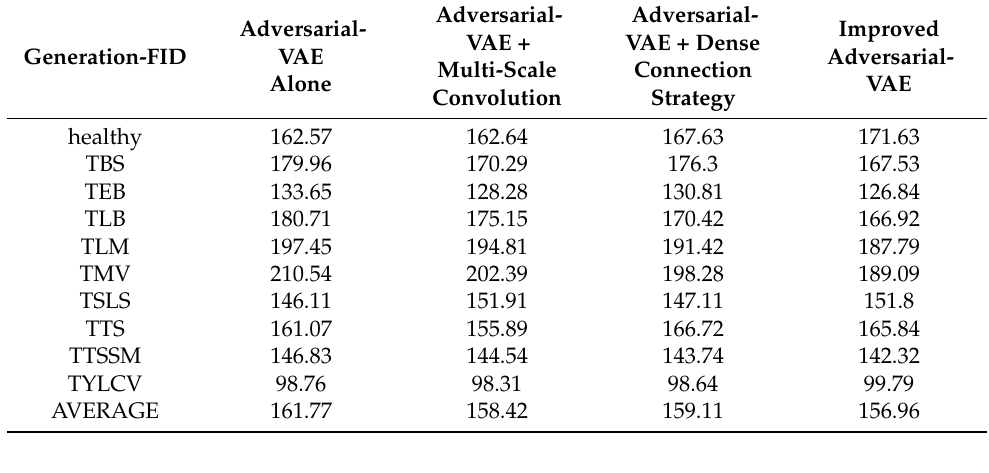
Table 7. Generation-FID comparison of the proposed generative method.